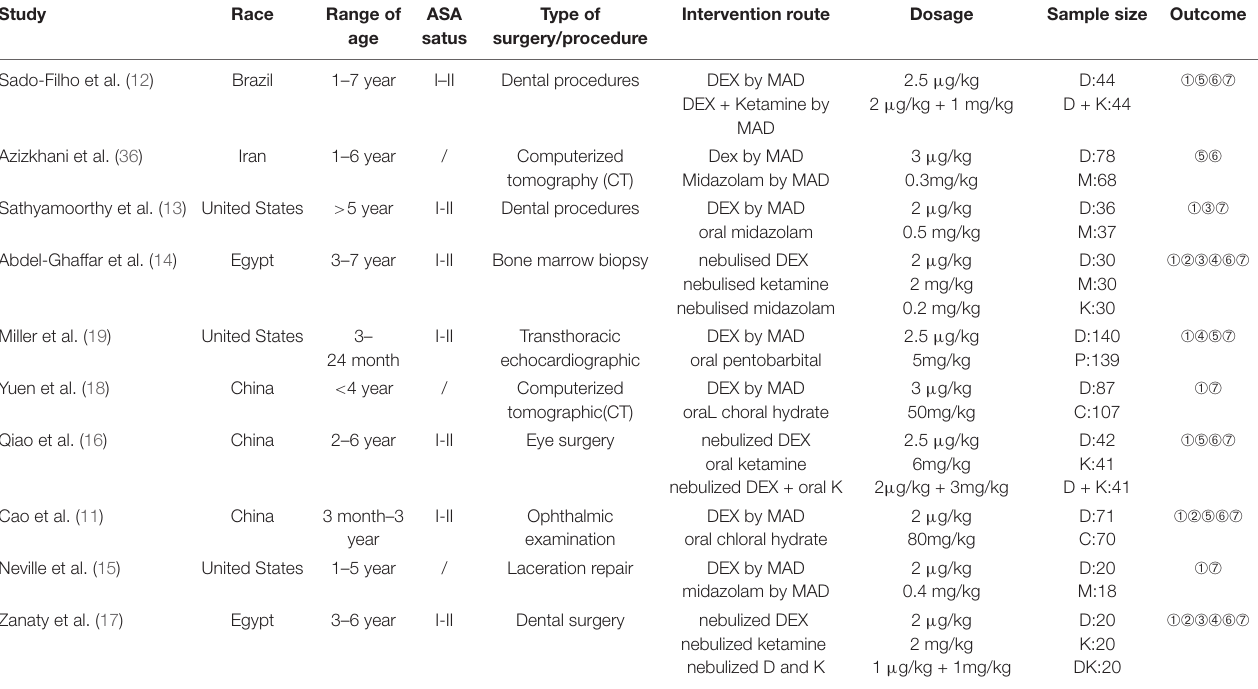
TABLE 1 | The characteristics of the included